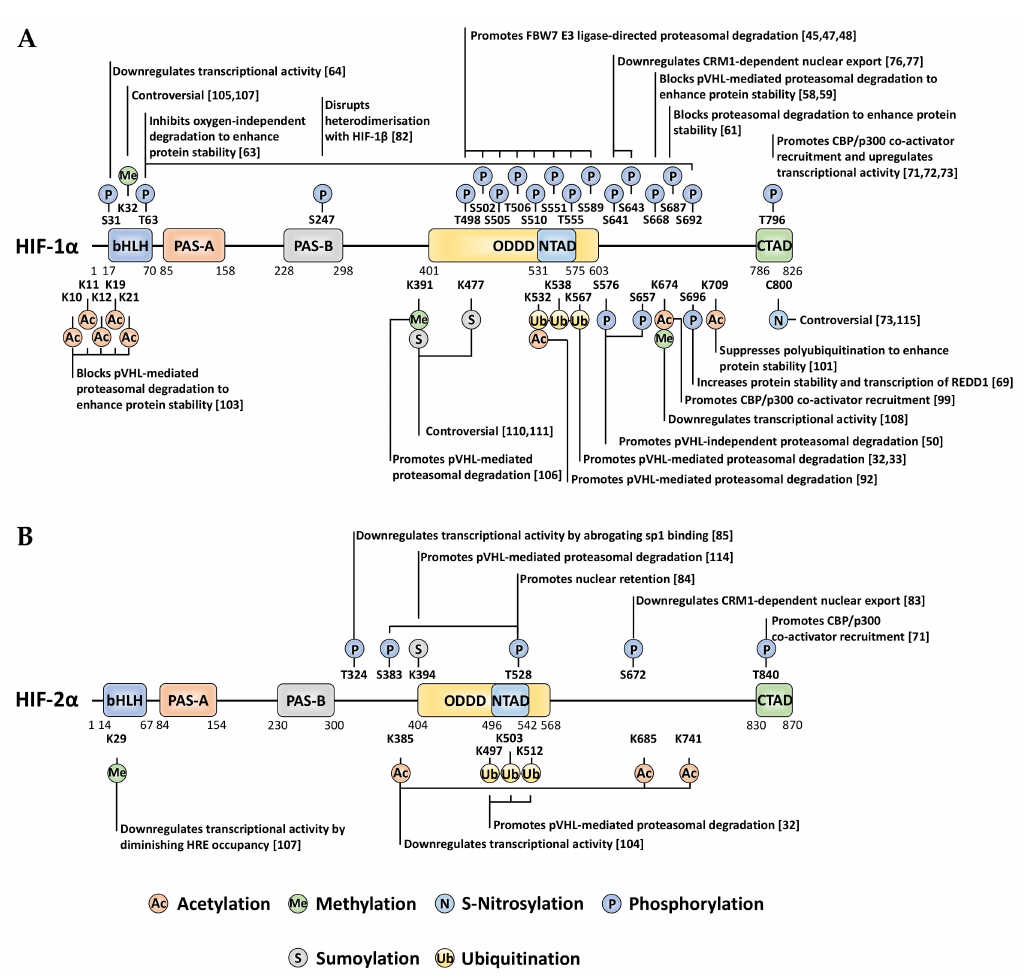
Figure 2. Localisation and function of non-canonical HIF- α post-translational modifications (PTMs) mapped onto full-length HIF-1 α ( A ) and HIF-2 α ( B ). When a given PTM has multiple publications stating conflicting functional outcomes, then the functionality is denoted as